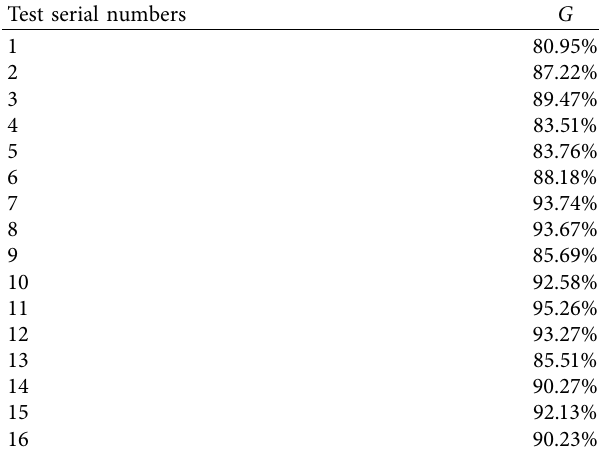
Table 3: Orthogonal test results.